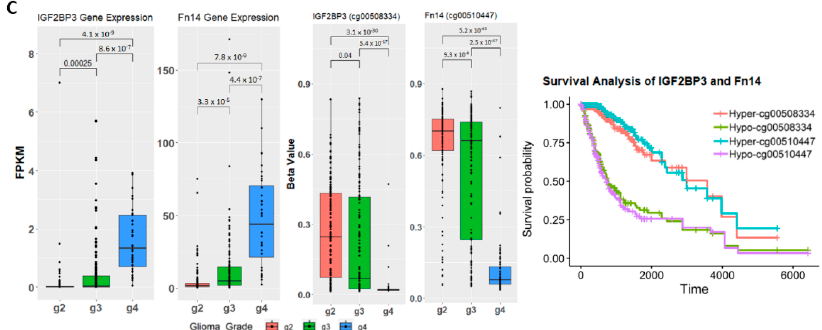
Figure 1. Correlation between gene expression and methylation level in the training set. ( A ) Gene expression of samples by glioma grade. Fragments Per Kilobase Million (FPKM) stands for Fragments Per Kilobase of transcript per Million mapped reads. The t.test method is used for statistical analysis when comparing two groups of samples. One-way analysis of variance (ANOVA) was used when comparing three groups of samples on one variable. ( B ) Methylation level of samples by glioma grade. Methylation level is represented by beta-value. One probe is selected to show the methylation level for SMOC1 gene and KCNA4 gene. ( C ) Boxplots of IGF2BP3 and Fn14 gene expression and methylation level on one of the associated probes. Kaplan-Meier plot measuring patient survival through the methylation level of CpG sites captured by cg00508334 for IFG2BP3 and cg00510447 for Fn14 . In Figure 6, the methylation status requirement shown in the schematic diagram is reversed but the subsequent analysis is not impacted. Figure 6 should be replaced with the following figure (Figure 2).